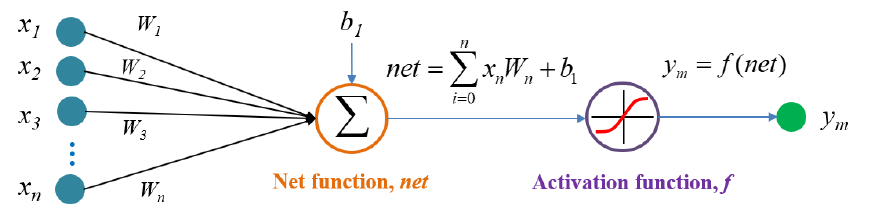
Figure 2 . Configuration of a neuron in the ANN. Figure 2. Configuration of a neuron in the